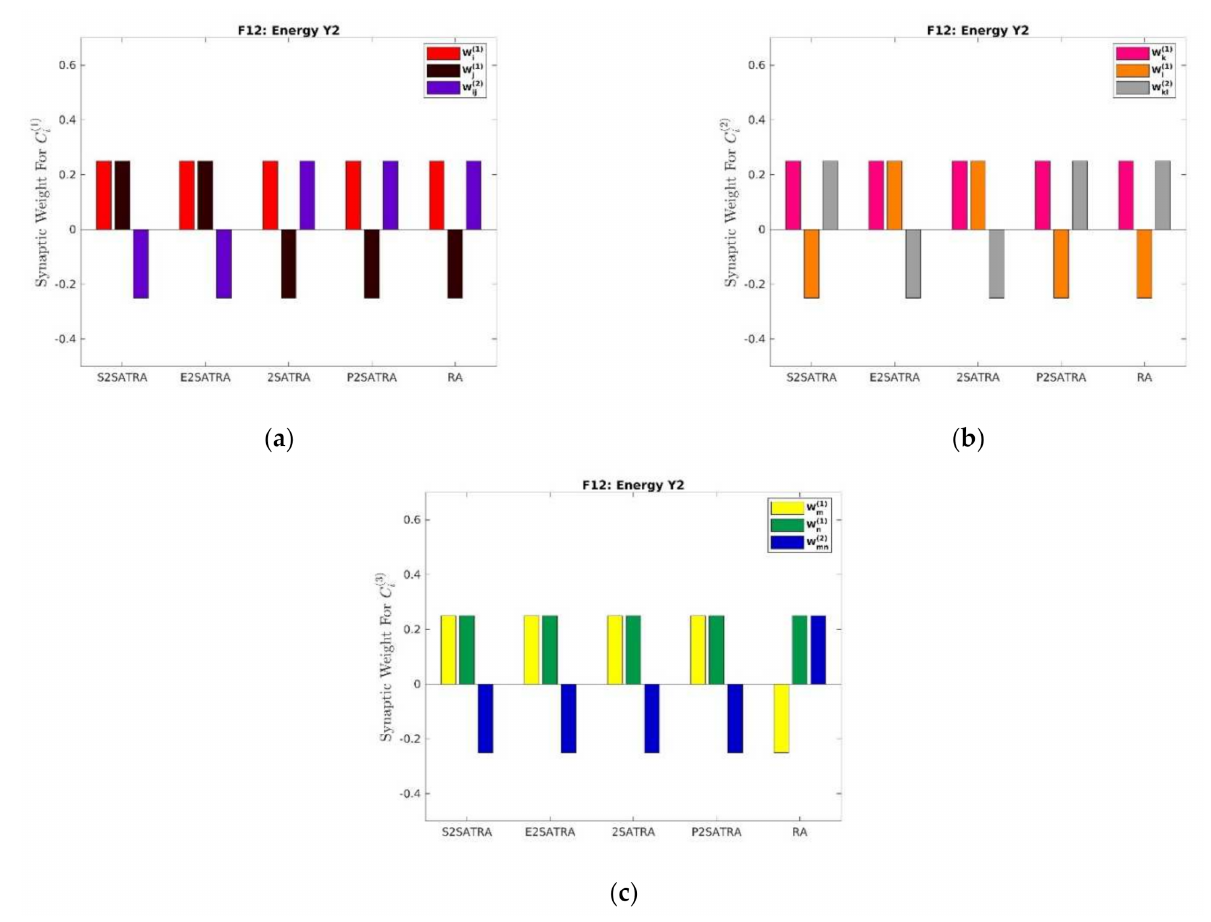
( 1 ) ( 2 ) ; ( b ) C and ( c ) C i i